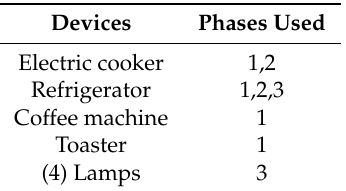
Table 6. List of electric devices with their configuration in our